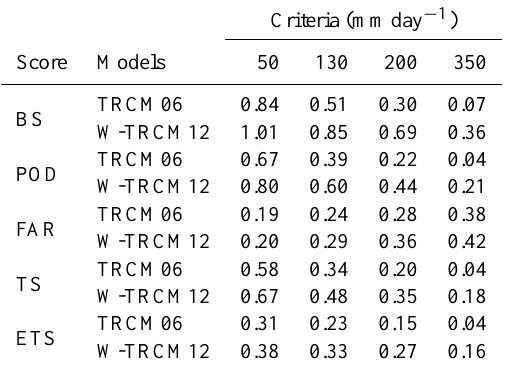
Table 4. Validation results for the statistical parameters of indepen- dent westward-moving typhoons that hit Taiwan in 2007–2011 us- ing contingency table analysis.